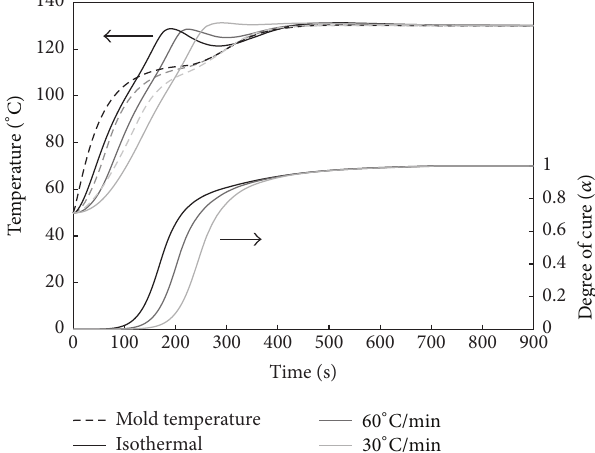
Figure 13: Cure profile of silicone resin increasing heating rate ( 𝑄 1